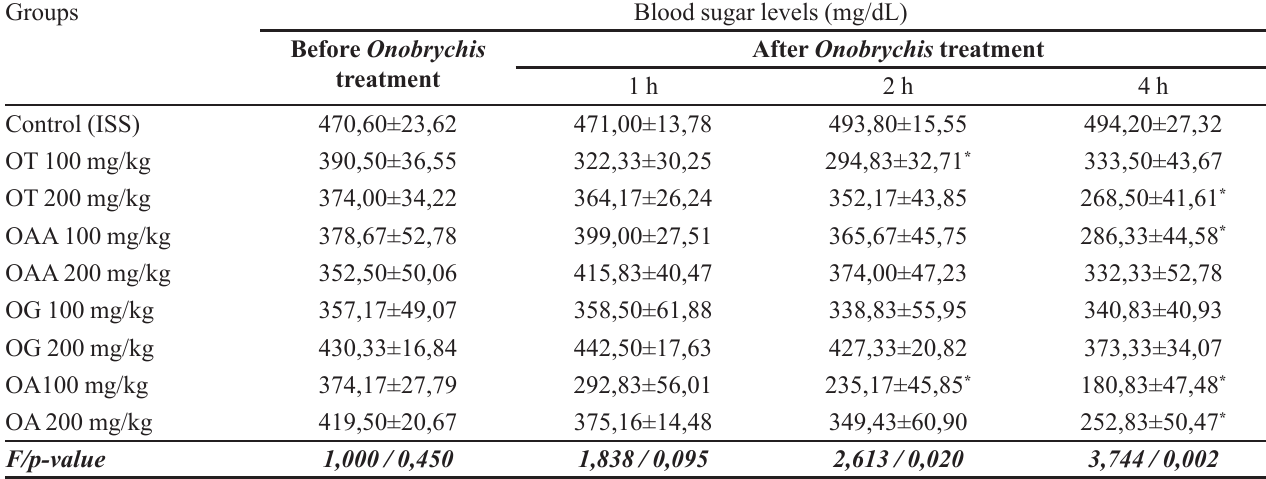
OA: O. albiflora , OAA: O. argyrea subsp. argyrea , OG: O. galegifolia, OT: O.